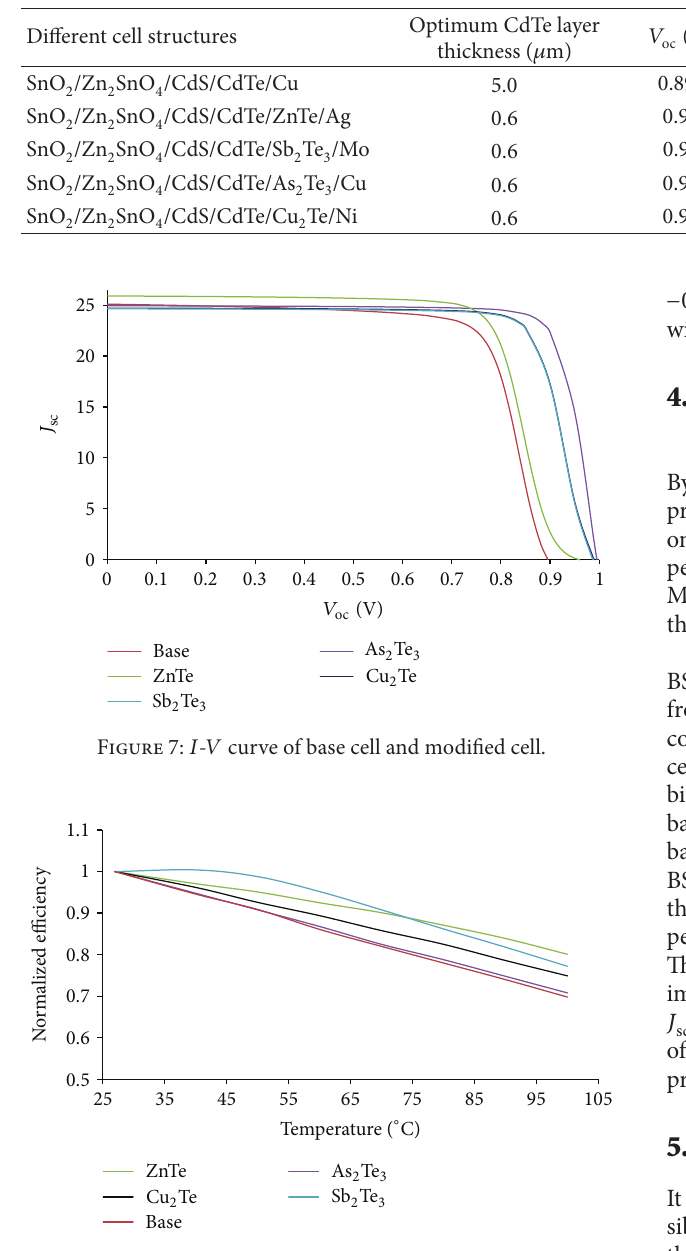
Figure 8: Effect of operating temperature on the proposed cell